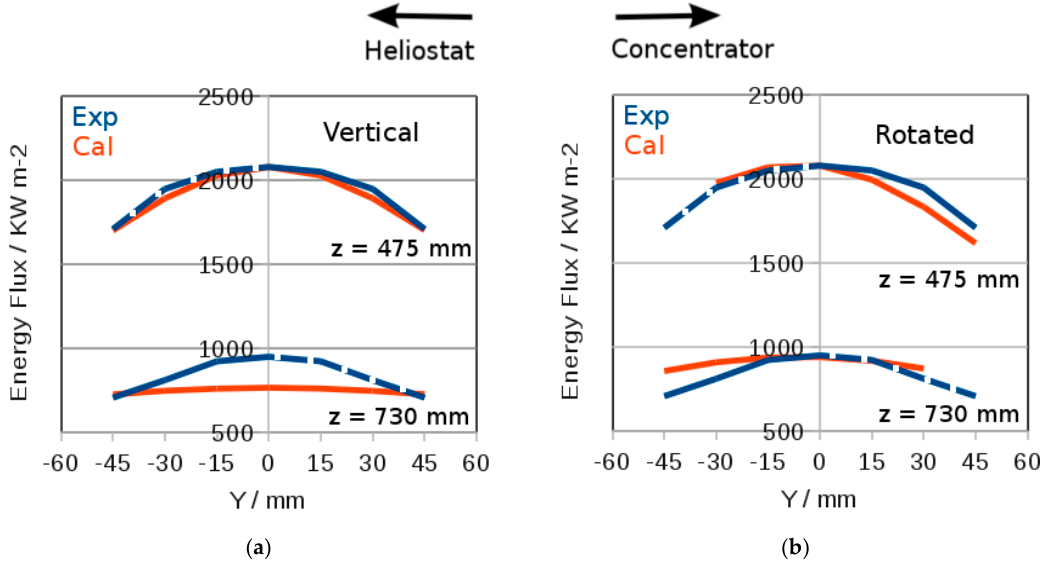
Figure 8. Calculated values (in orange) of energy flux (in kW / m 2 ) for a vertical ( a ) and a 13.2 ◦ rotated beam ( b ), compared with experimental values (in blue), for planes z = 475 mm and z = 730 mm below the concentrator axis. Note that experimental and calculated curves were shifted horizontally so that all maxima coincide. Moreover, dotted segments describe experimental values replicated by symmetry to facilitate comparison.